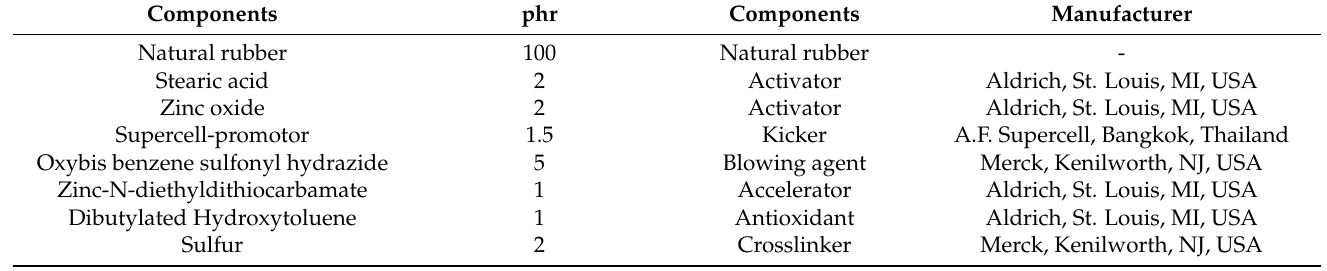
Table 2. Formula of rubber compounds for the core layer of the SIP. The component quantity shown in the table was in the unit of part per hundred parts of rubber (phr). The functions of each component were also reported. Components phr Components Manufacturer